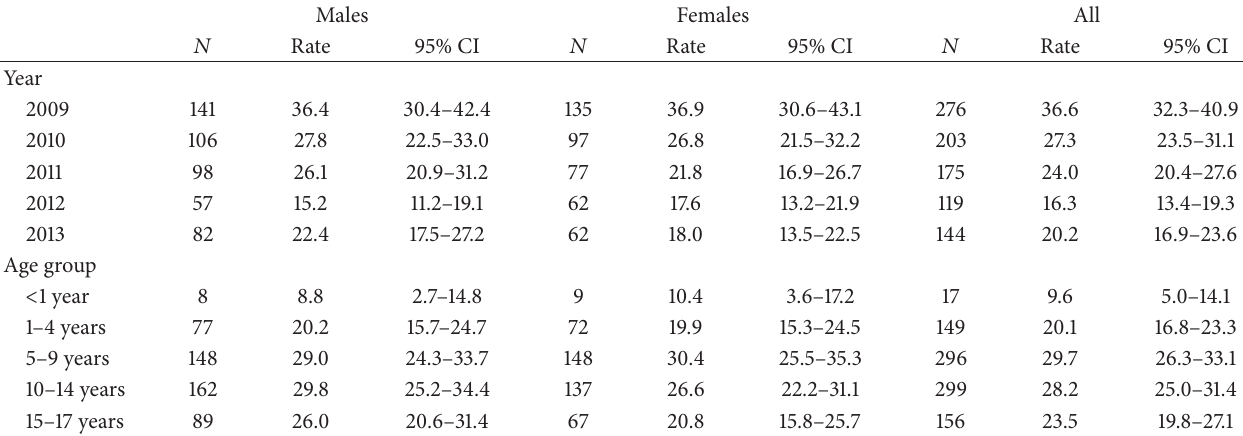
Table 1: Estimated T1DM incidence rates (per 100,000) among subjects < 18 years, by sex, year, and age group. Apulia, Italy, 2009–2013. Males Females All